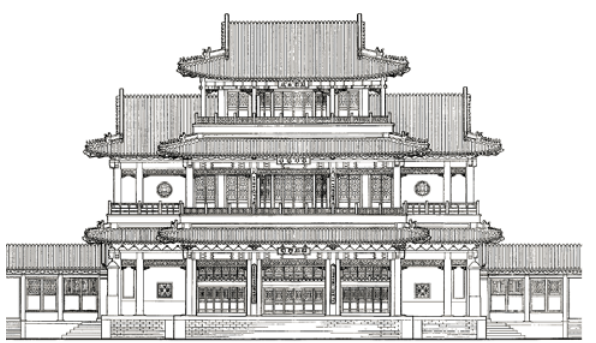
Fig.3. A survey drawing of Gaichun Yuan 赅春园 (Garden of Gathering the Spring) , 1887 (Source: National Library of China ) 2.2 Records from 1912 to 2004 After the collapse of the Qing Dynasty, The Summer Palace was open to the public. For the purposes of management, restoration, research and display, managers and researchers have, from various perspectives, recorded information on the buildings in the Summer Palace using modern drawing standards. (Fig. 4, 5, 6)